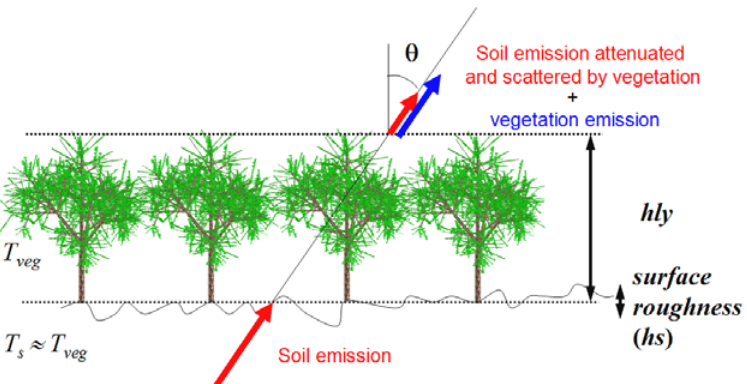
Figure 1. Soil + vegetation configuration in the τ - ω